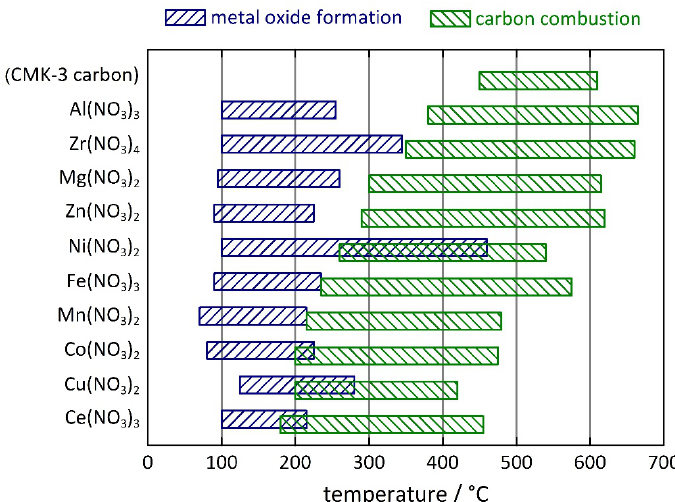
Figure 4. Comparing chart of the temperature intervals for the thermally induced formation of metal oxides from metal nitrates inside the pores of mesoporous CMK-3 carbon (blue bars) and for the thermal combustion of the carbon matrix (green bars). Table 1. Temperature intervals of the thermally induced conversion of metal nitrates into metal oxides in the pores of mesoporous CMK-3 carbon and of the thermal combustion of the carbon matrix. Temperature (°C) of metal oxide formation Temperature (°C) of carbon combustion Sample onset offset Literature * onset offset CMK-3